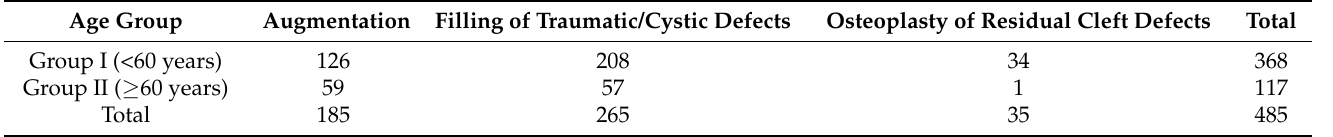
Table 1. Indications for iliac crest bone